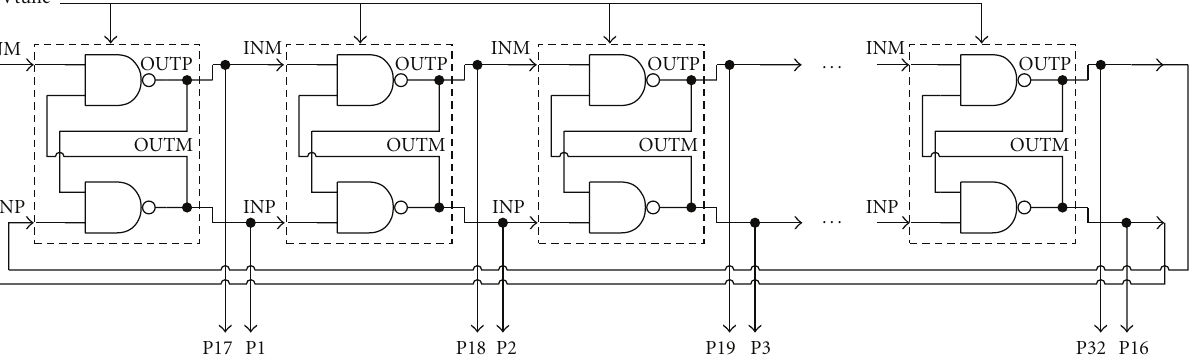
Figure 8: Block diagram of multiphase VCO.